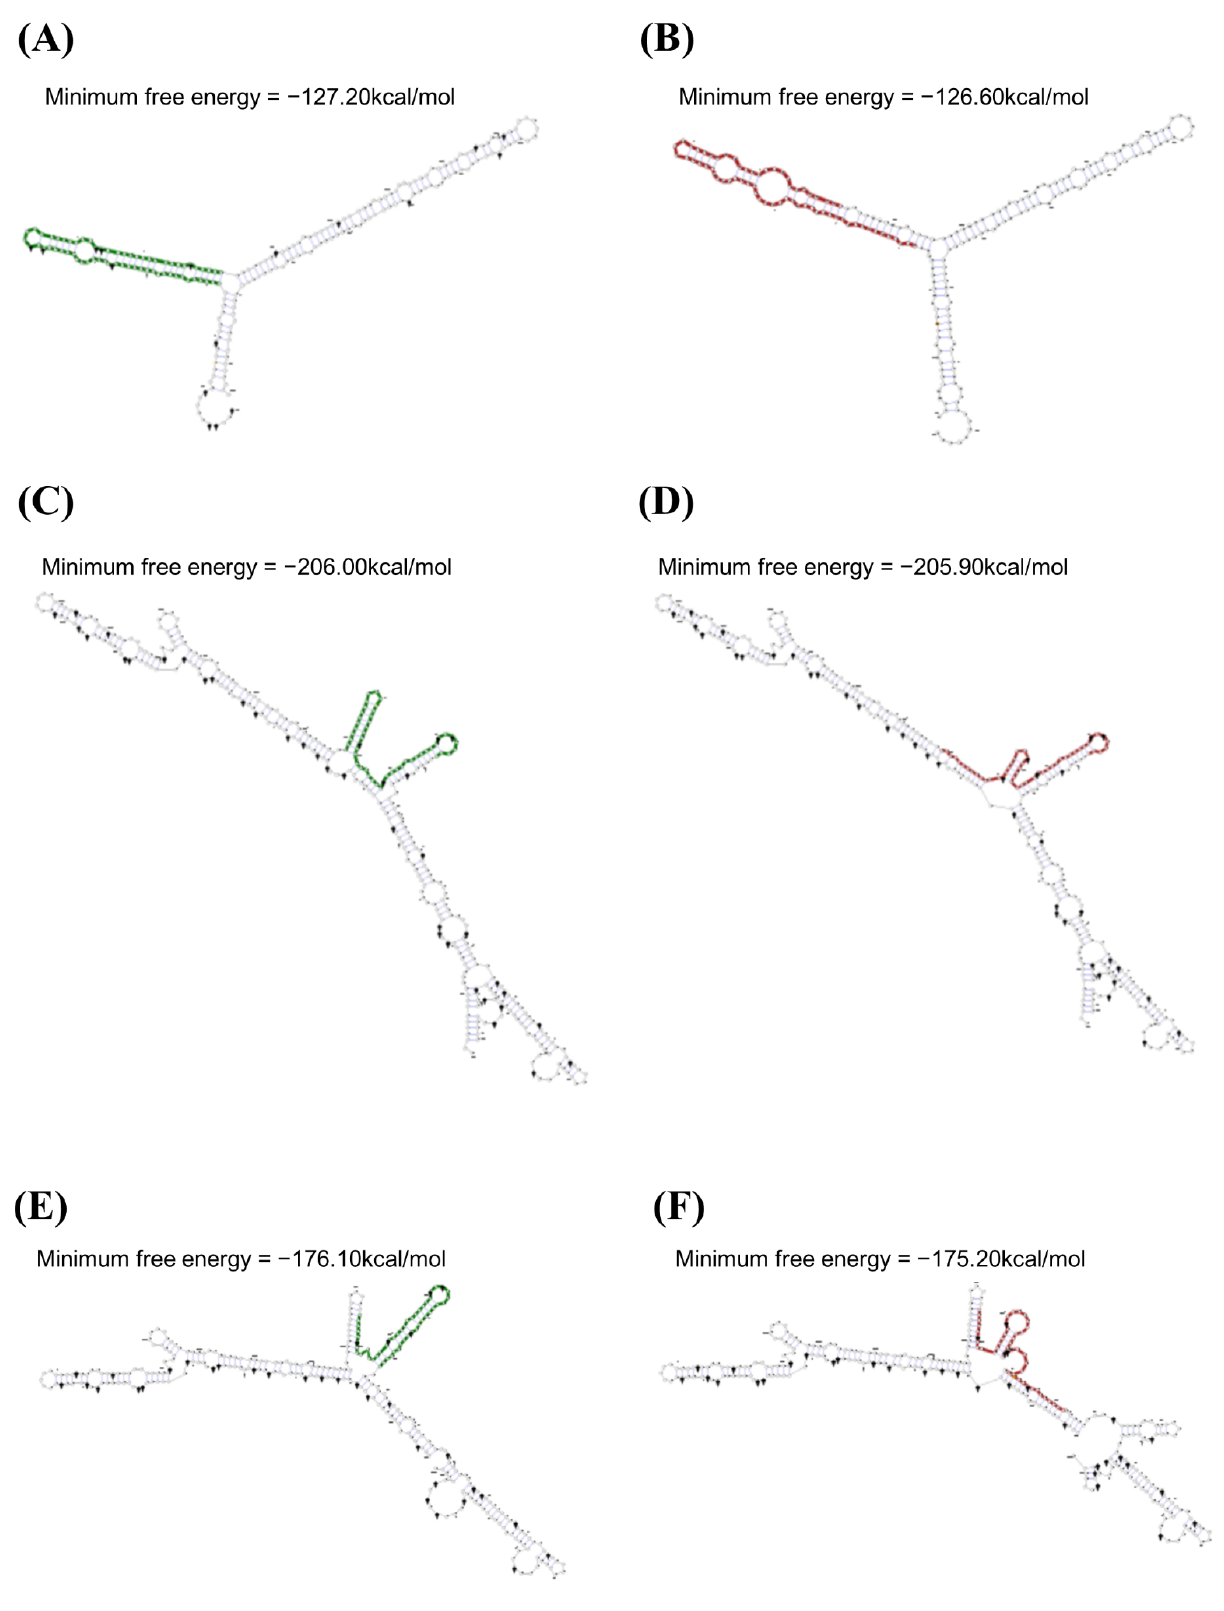
Figure 2. Analysis of the mRNA secondary structure of the feline SPRN gene according to haplotypes in the feline SPRN polymorphisms. ( A ) Minimum free energy and mRNA secondary structure of the feline SPRN gene with the CCC haplotype (1–215 nt). ( B ) Minimum free energy and mRNA